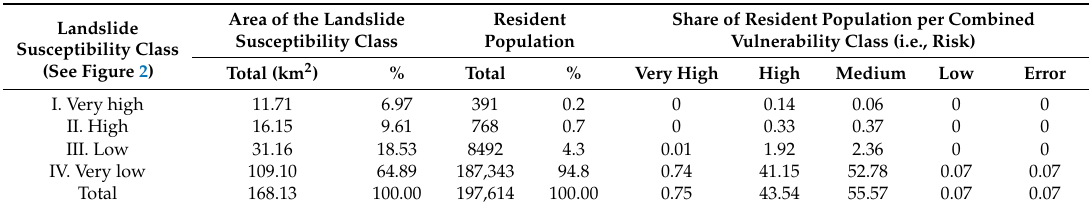
Table 6. Landslide risk analysis for the resident population, considering the combined vulnerability for 3-metre-deep landslides (see Figure 5b); adapted from Koks and co-authors [43].